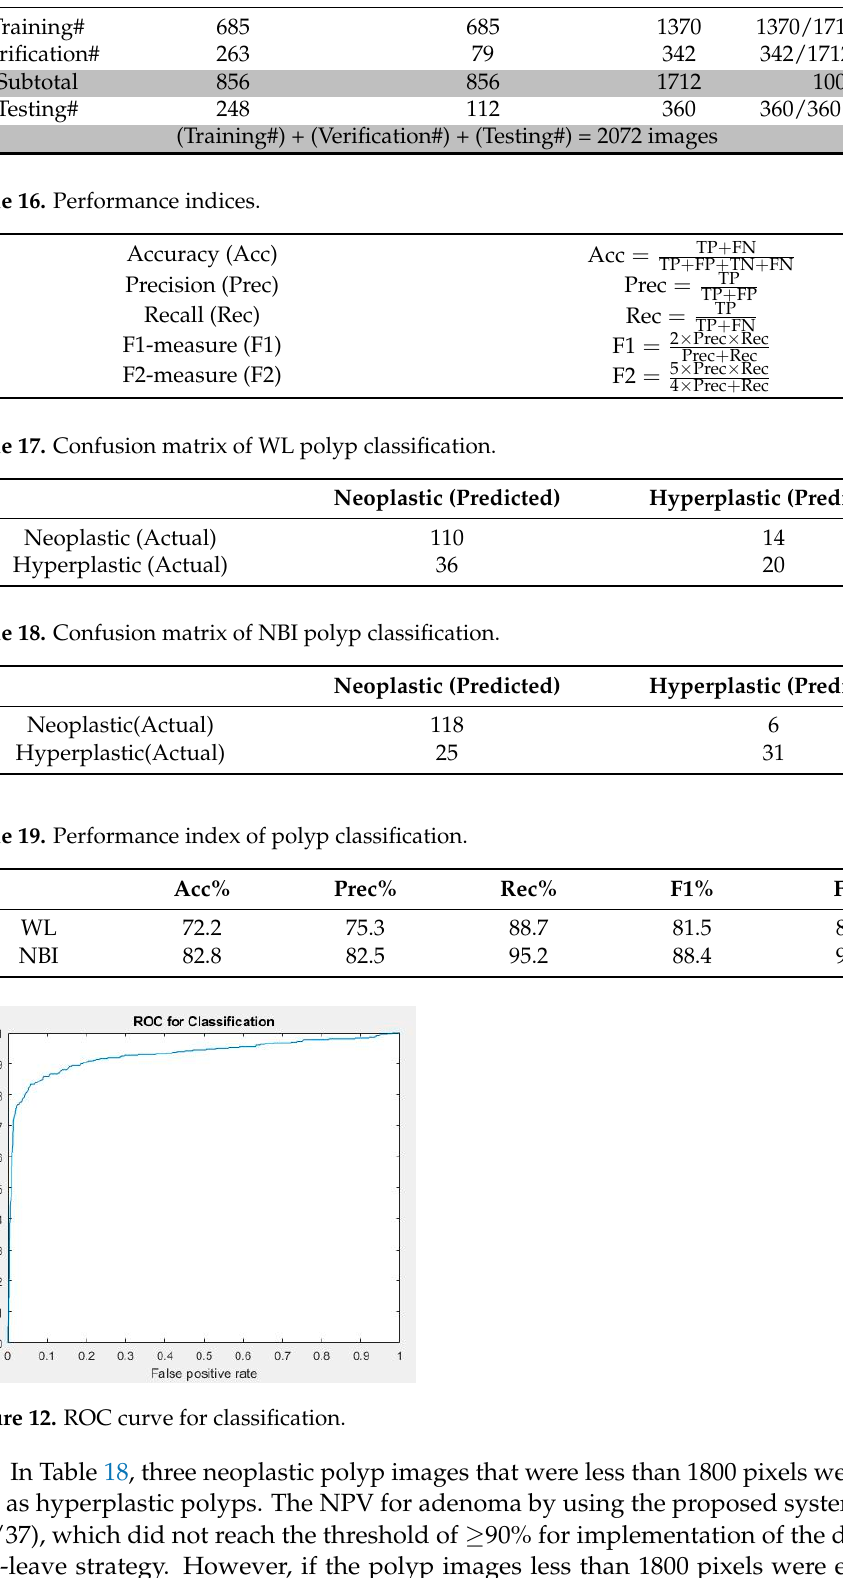
Table 16. Performance indices.